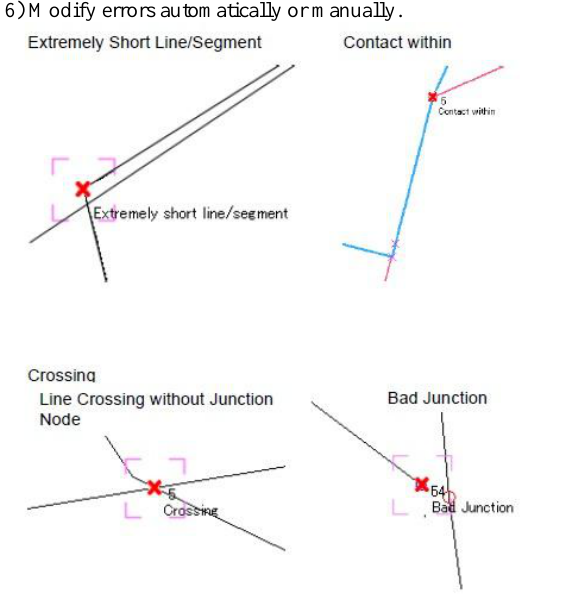
Figure 7: Examples of errors detected by